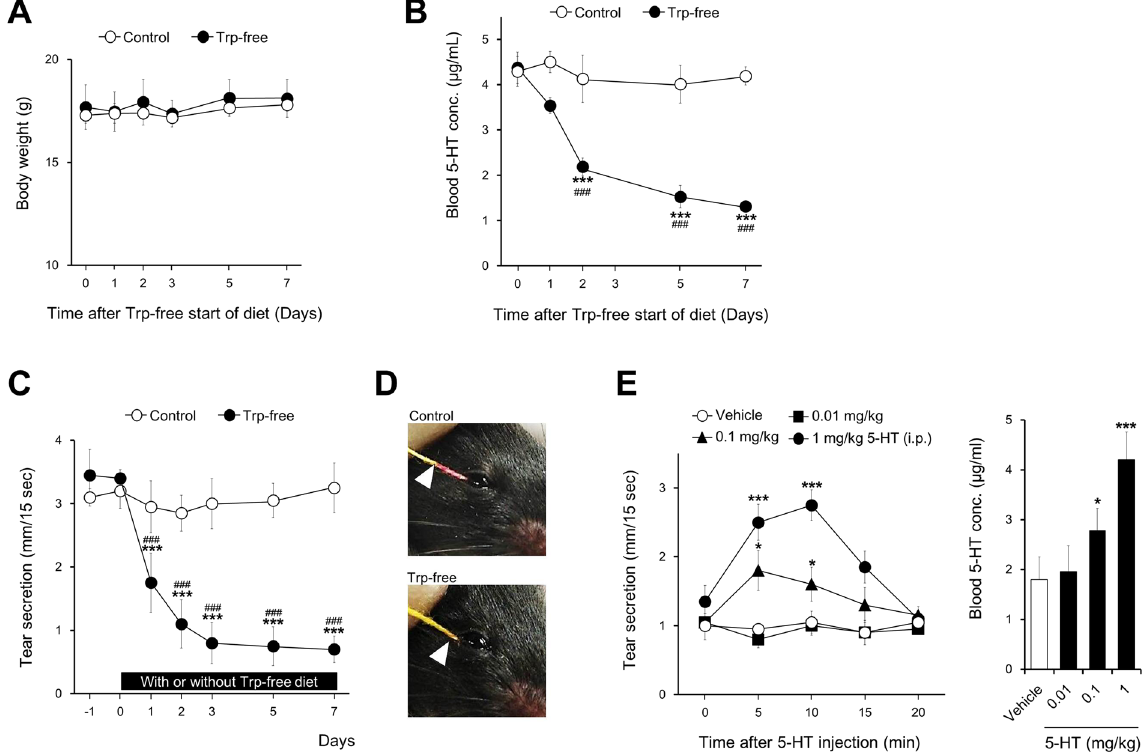
Figure 1. Effects of a Trp-free diet on tear secretion. Mice were given a standard diet (control group) or Trp- free diet (Trp-free group) for 7 days after the acclimatization period. Changes in blood 5-HT concentration ( A ) and body weight ( B ). ( C ) Changes in tear secretion. Each measurement was performed during 7 days of feeding with a standard diet or Trp-free diet. Open and solid symbols show the control group and Trp-free group, respectively ( A – C ). ( D ) Representative photographs of tear secretion patterns measured with a cotton thread at day 7 after changing to a Trp-free diet. The arrow indicates the wetted length due to tear secretion. ( E ) Stimulated tear secretion by 5-HT. 5-HT was injected 2 days after changing to a Trp-free diet. The line chart shows the changes in tear secretion after injection with vehicle (saline, open circles) and 5-HT at the dosage of 0.01 mg/kg (solid squares), 0.1 mg/kg (solid triangles), and 1 mg/kg (solid circles). The bar chart shows the blood 5-HT concentration 10 minutes after injection with vehicle (open column) or 5-HT (solid columns) at each dosage corresponding to the line chart. All data represent the mean ± SD, n = 6 mice. * P < 0.05, *** P < 0.001 versus control ( B , C ). # P < 0.001 versus day 0 ( B , C ), * P < 0.05, *** P < 0.001 versus vehicle ( E